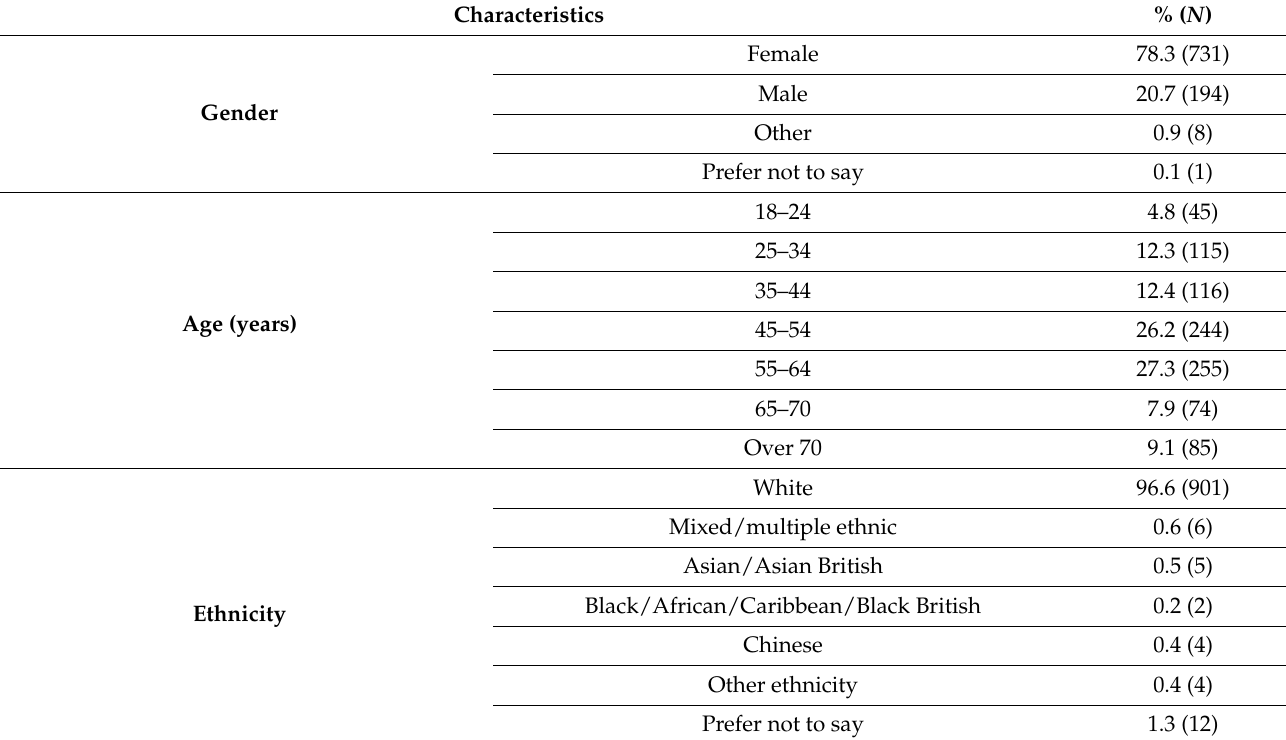
Table 1. Participant characteristics ( n =